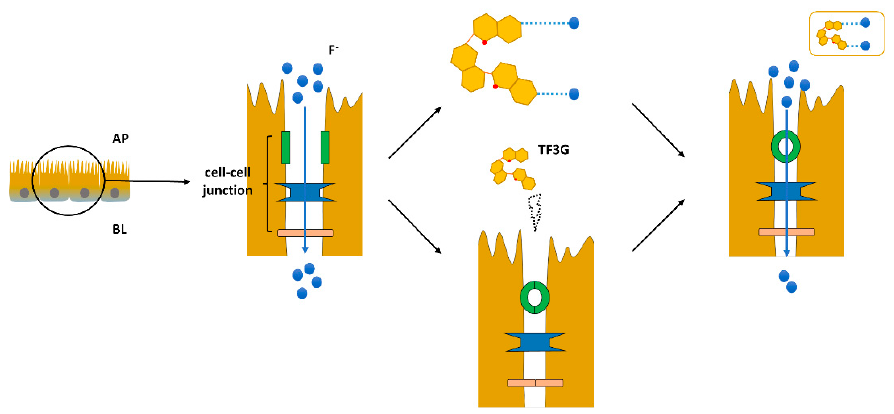
Figure 8. Schematic diagram of TF3G regulating intestinal fluoride absorption. Supplementary Materials: The following supporting information can be downloaded at: www.mdpi.com/xxx/s1, Figure S1: Thermal spectrum of F − -TFs titration process and combined iso- therm; Table S1: Primers used for qRT-PCR in this study; Table S2: TF3G distribution of the main peaks of Raman spectra with di ff erent concentrations of F- and their vibration mode; Table S3: TF3 ′ G distribution of the main peaks in the Raman spectra with di ff erent concentrations of F − and their vibration mode ; Table S4: TFDG distribution of the main peaks in the Raman spectra with di ff erent concentrations of F − and their vibration mode. Author Contributions: Conceptualization, F.Y. and C.Y.; methodology, F.Y. and C.Y.; validation, F.Y.; formal analysis, F.Y.; investigation, F.Y., H.J. and S.D.; data curation, F.Y. and C.Y.; writing— original draft preparation, F.Y. and L.Z.; writing—review and editing, C.Y. and N.D.; visualization, F.Y. and L.Z.; supervision, C.Y. and N.D.; project administration, C.Y. and N.D.; funding acquisition, C.Y. All authors have read and agreed to the published version of the manuscript. Funding: This research was funded by National Natural Science Foundation of China, grant number 31972463.